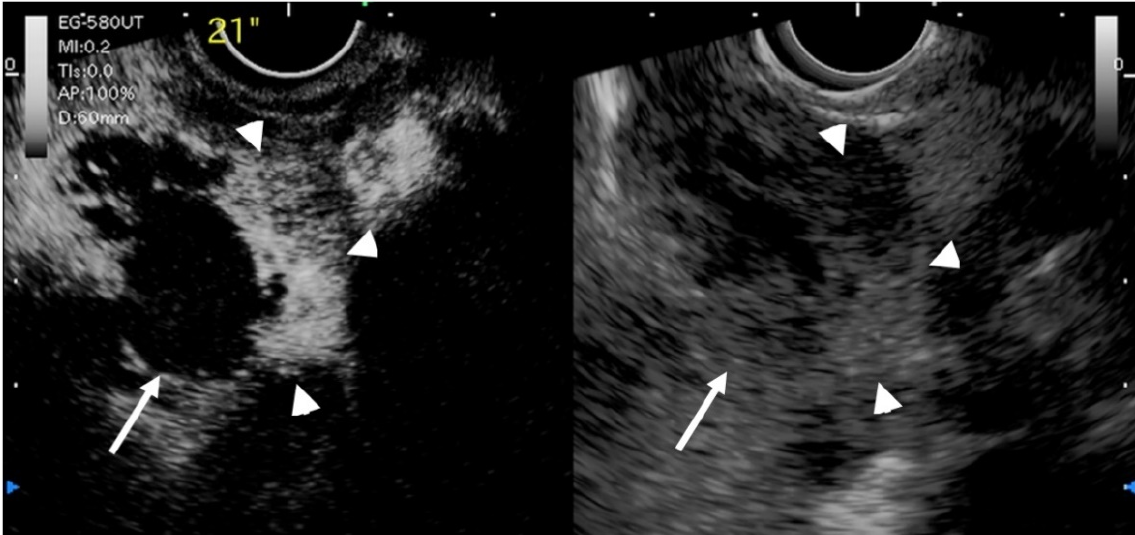
Figure 8. EUS image of GB carcinoma. Irregular wall-thickening of the GB (arrowhead) is observed. In the conventional EUS image ( right ), a structure is found inside the GB and the lumen is unknown. The contrast-enhanced harmonic image 21 s after the injection of Sonazoid ® ( left ) shows heterogeneous enhancement in the thickened wall (arrowhead). The structure inside the GB is not enhanced and can be diagnosed as biliary sludge (arrow) rather than a